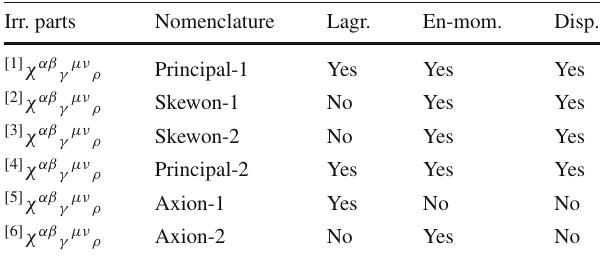
Table 1 Physical identifications of the irreducible parts of the consti- tutive tensor χ αβ γ μν ρ Irr.